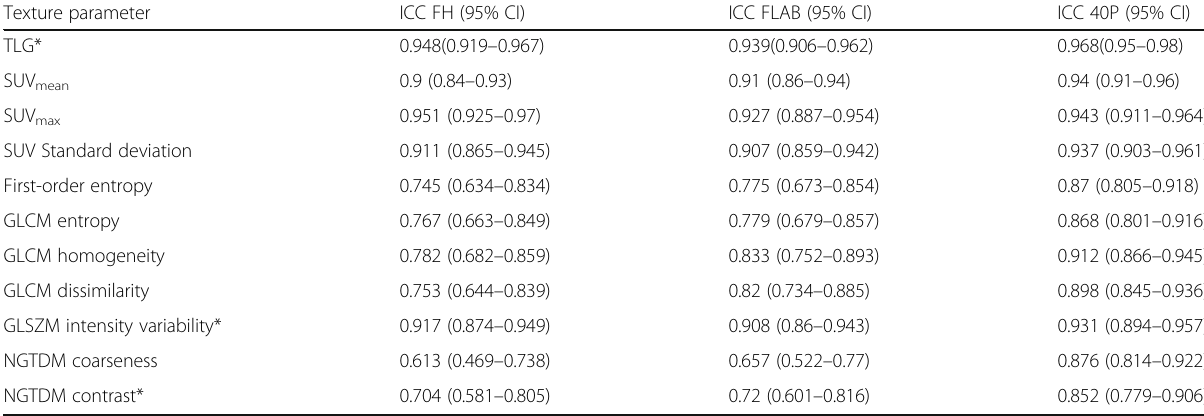
Table 2 Comparison of ICC values of 11 commonly reported texture parameters derived with 3 contending segmentation algorithms Texture